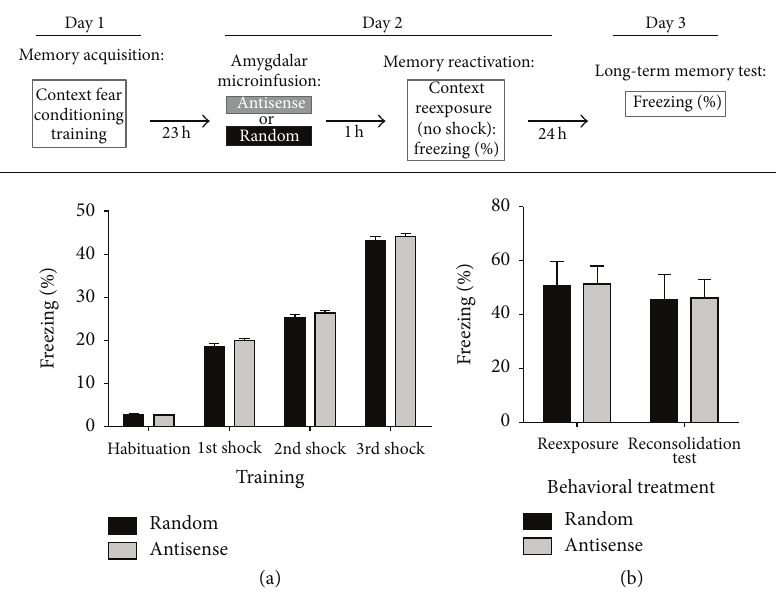
Figure 5: RAG1 antisense amygdalar treatment does not interfere with reconsolidation of context fear conditioning. To test the effects of RAG1 gapmer antisense treatment on memory reconsolidation of context fear conditioning, another set of animals was bilaterally implanted with cannulas to target the amygdala. Top panel: diagram depicting the experimental design. On day 1, mice were trained in context fear conditioning and immediately returned to their home cages. Antisense or random oligonucleotides were microinfused into the amygdala 1h beforememoryreactivationonday2.TheeffectofantisenseorrandomoligonucleotidetreatmentonLTMreconsolidationwasassessedonday 3, 48 h after conditioning. (a) On day 1, mice were microinfused with saline 1h before training and returned to their home cages immediately after conditioning. Two-Way RM ANOVA and Bonferroni posttesting demonstrated that the infusions did not impair the animals’ response in developing and expressing fear during the conditioning experience (Treatment Assignment Factor: 𝐹(1,8.194) = 3.979 , 𝑃 > 0.05 ; Training Factor 𝐹(3,3134) = 1725 , ∗∗∗ 𝑃 < 0.0001 ; and Interaction: 𝐹(3,1.069) = 0.5881 , 𝑃 > 0.6 ). (b) On day 2, animals were microinfused with either random or antisense gapmer oligonucleotides 1h prior to a 90 s reexposure period to the conditioning chamber in order to induce memory retrieval and returned to their home cages. For the reconsolidation test, on day 3 (48 h after training), mice were reexposed to the conditioning chamber (CS) for 2 min to measure freezing responses. No significant differences between the freezing responses of antisense or random gapmer oligonucleotide treated animals on day 2 (b) or on day 3 (b) were observed (Two-Way ANOVA: Treatment Factor: 𝐹(1,3.068) = 0.009017 , 𝑃 > 0.9 ; Training Factor 𝐹(1,146.5) = 0.4307 , 𝑃 > 0.5 ; Interaction: 𝐹(1,0.001515) = 0.00004453 , 𝑃 > 0.9 ). Bonferroni posttesting identified no difference between treatments in the reexposure and reconsolidation tests, respectively ( 𝑃 > 0.05 , each